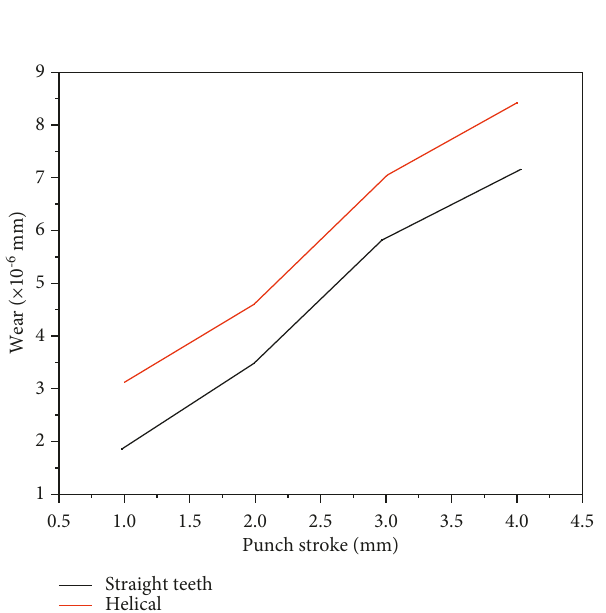
Figure 2: Comparison of wear amount of straight tooth and oblique tooth dies under different punch stroke conditions.